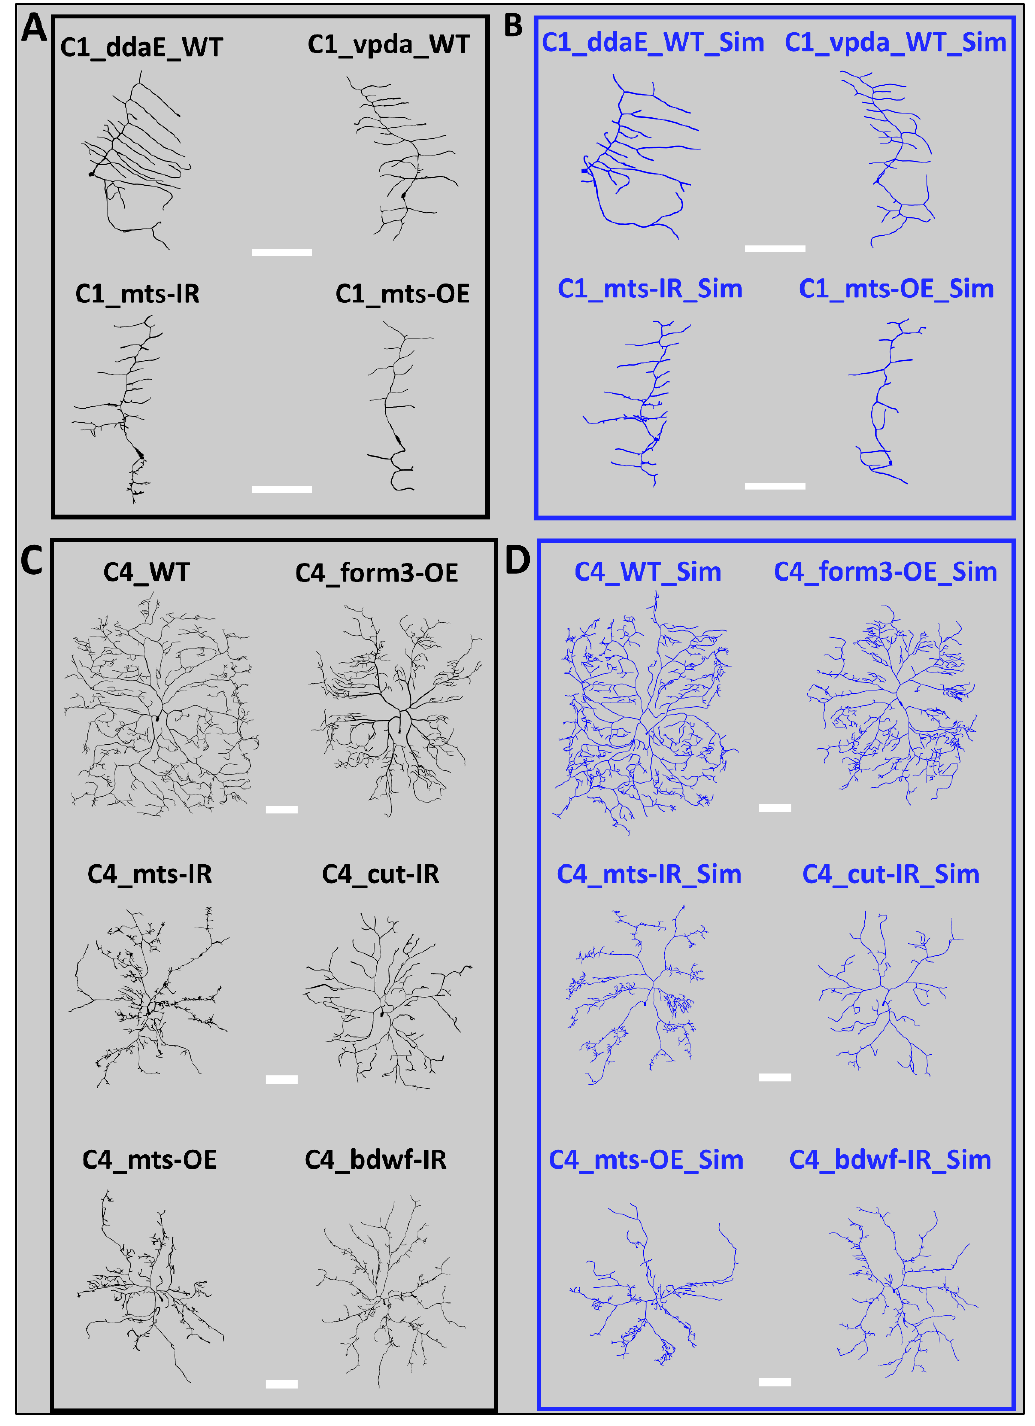
Figure 5. Morphological Comparison Between Real and Simulated Neurons. ( A ) Representative real neurons (black) from the four class I neuron groups (ddaE WT, vpda WT, vpda mts-IR, and vpda mts-OE). ( B ) Representative simulated neurons (blue) from the four class I neuron groups (ddaE WT, vpda WT, vpda mts-IR, and vpda mts-OE). ( C ) Representative real neurons (black) from six Class IV neuron groups (Class IV WT, form3-OE, mts-IR, cut-IR, mts-OE, and bdwf-IR). ( D ) Representative simulated neurons (blue) from six Class IV neuron groups (Class IV WT, form3-OE, mts-IR, cut-IR, mts-OE, and bdwf-IR). All scale bars (white rectangles) represent 100 µm.